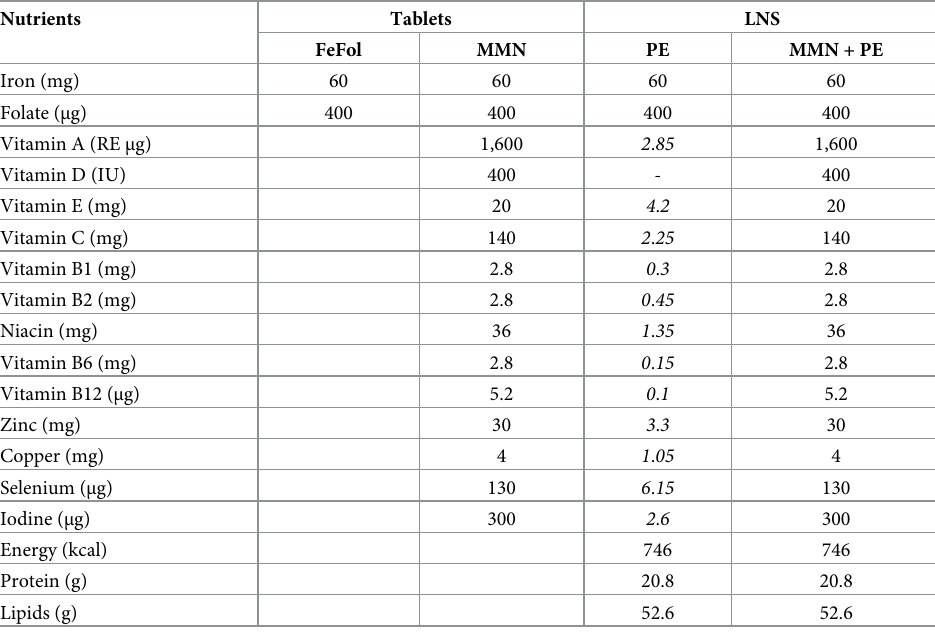
Table 1. Nutritional composition of the allocated daily intake of pregnancy supplements. Nutrients Tablets LNS FeFol